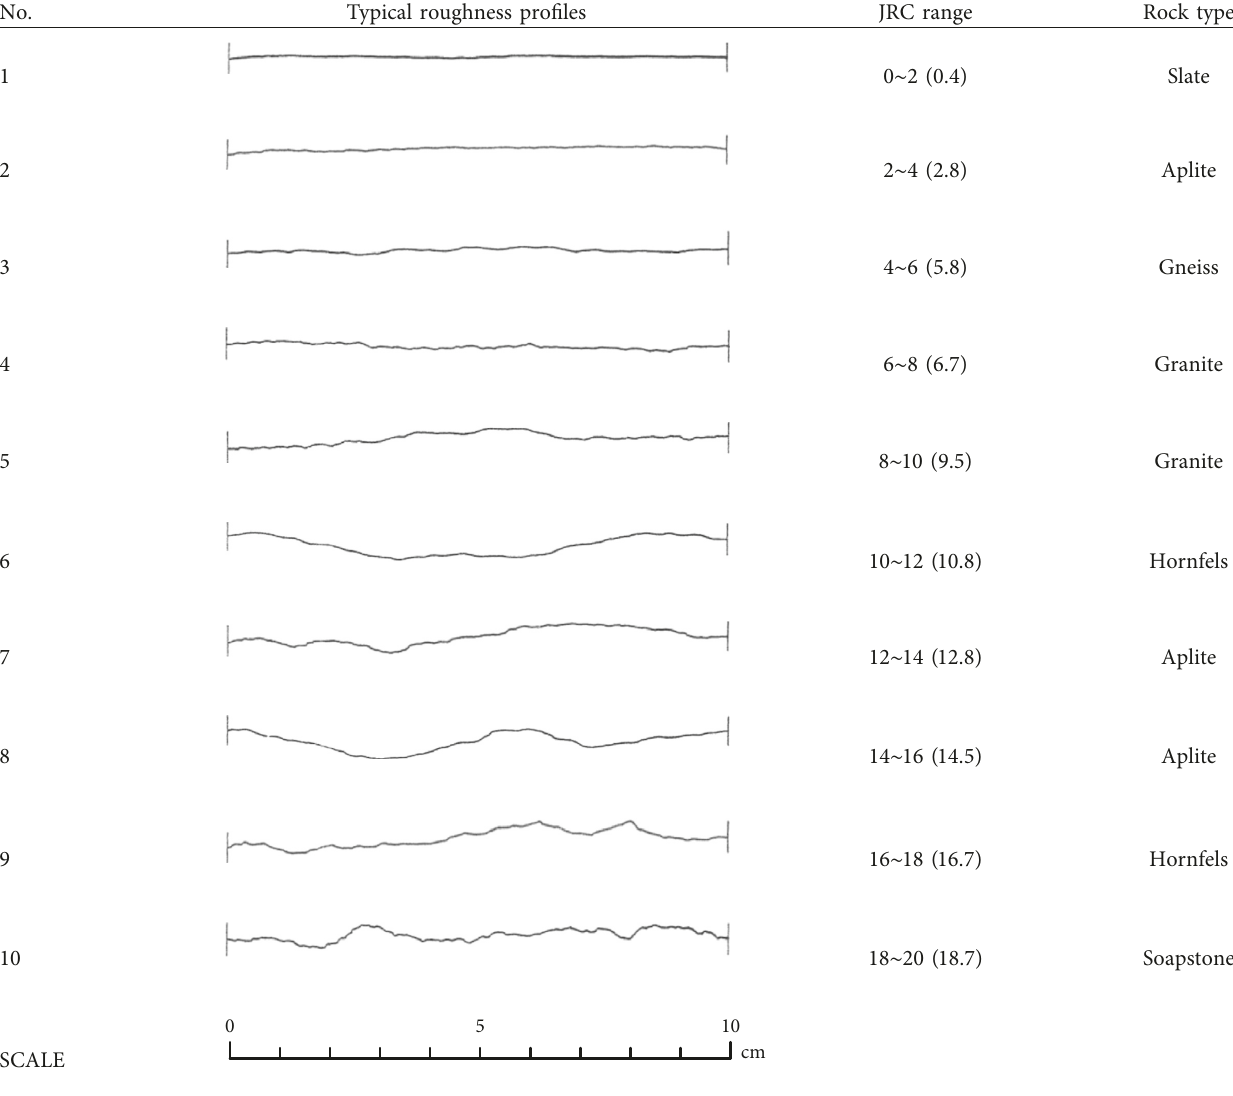
Table 1: 10 standard roughness joint profiles